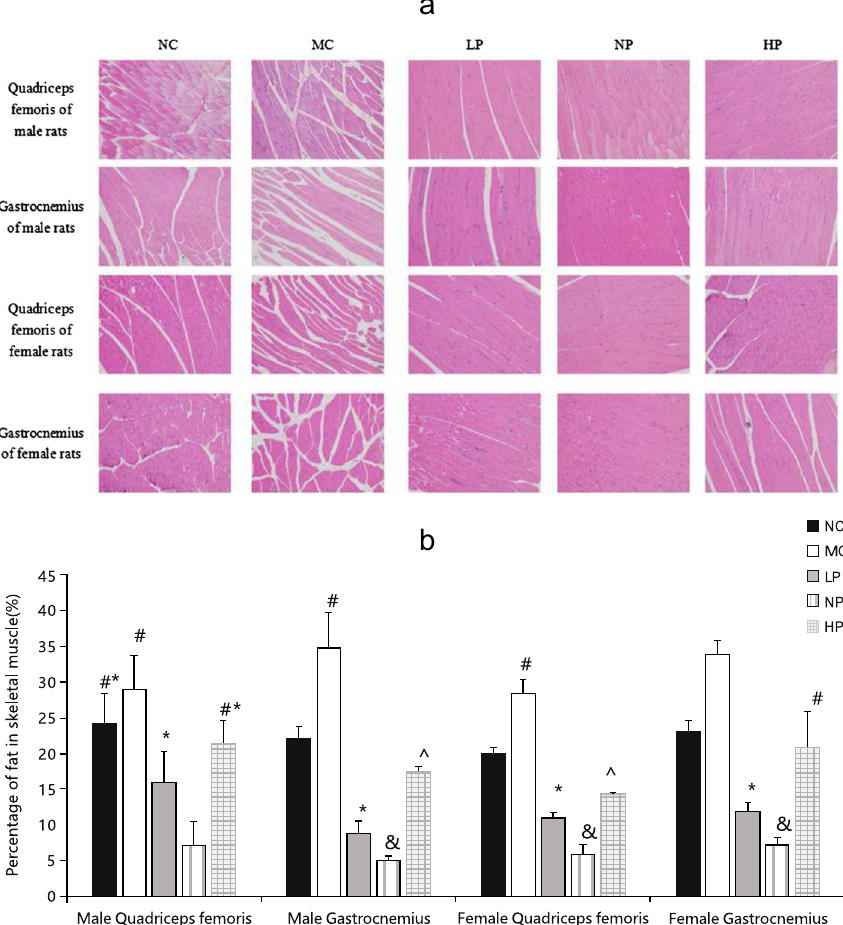
Figure 2. Histological analysis of the skeletal muscles. ( a ) The H-E staining of quadriceps femoris and gastrocnemius muscles of rats (100 ×). ( b ) Statistical analysis of fat in skeletal muscles. Mean values of the same sex with different superscript symbols (#,*, & and ^) were significantly different ( P <